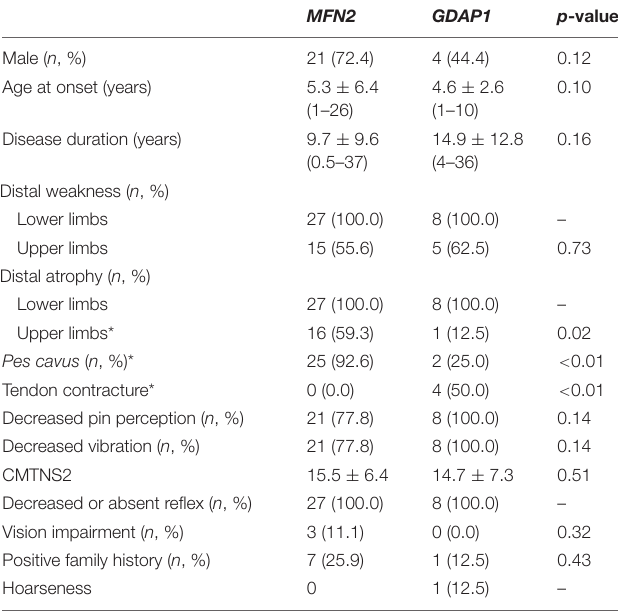
TABLE 1 | Comparison of clinical features of the patients with CMT2A and CMT2K.